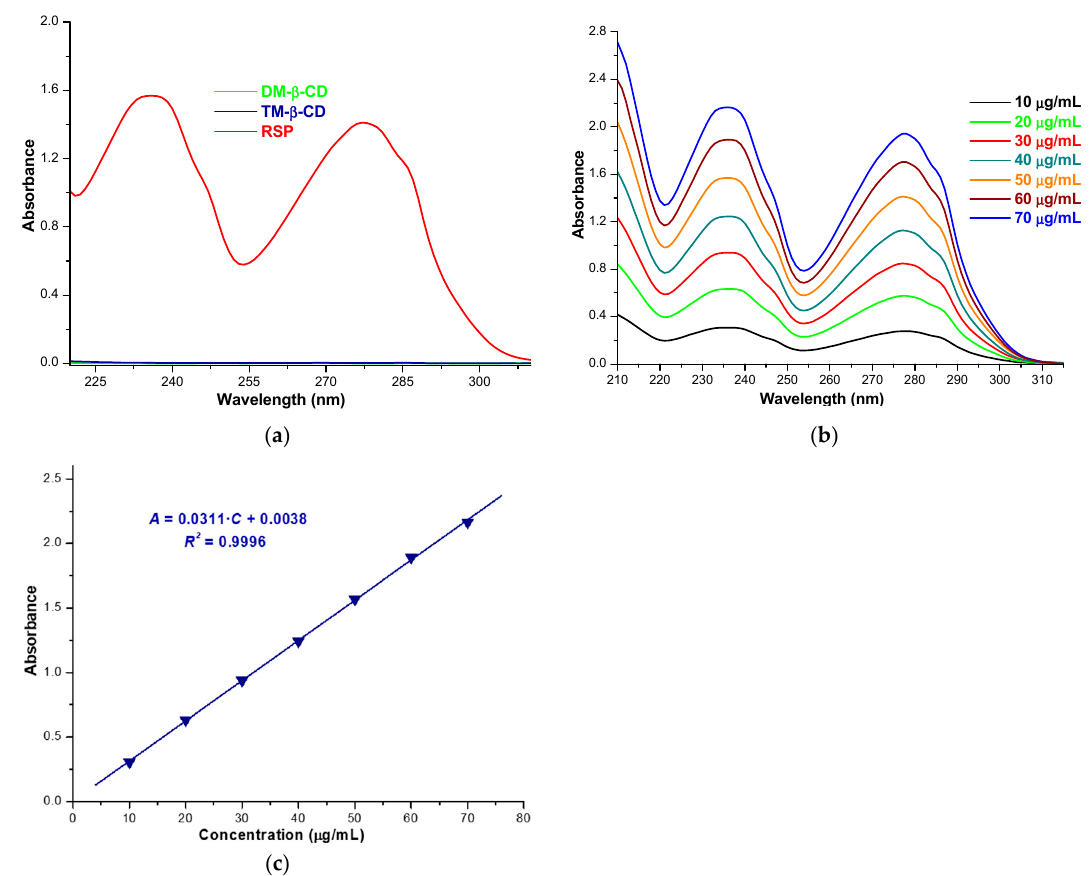
Figure 8. Absorption spectra of: DM- β -CD 130 µ g / mL, TM- β -CD 142 µ g / mL, RSP 30 µ g / mL in phosphate bu ff er 0.1 M (pH 7.4), at 25 ◦ C ( a ); RSP 10–70 µ g / mL in phosphate bu ff er 0.1 M (pH 7.4), at 25 ◦ C ( b ); RSP calibration curve ( c